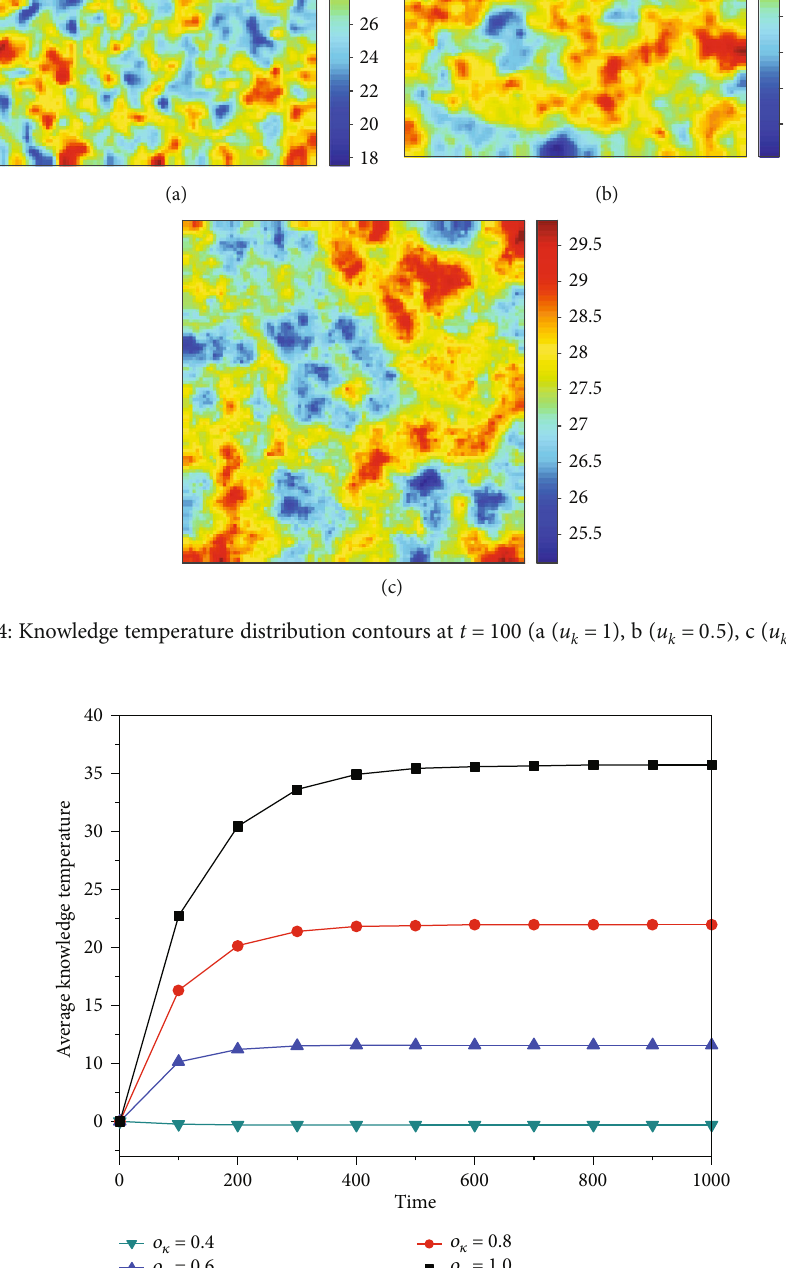
Figure 5: Organization-average knowledge temperature vs. time on di ff erent organizational knowledge a ffi nity coe ffi